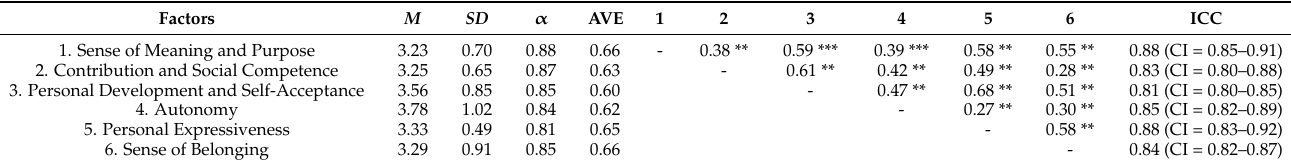
Table 4. Descriptive statistics, reliability and temporal stability